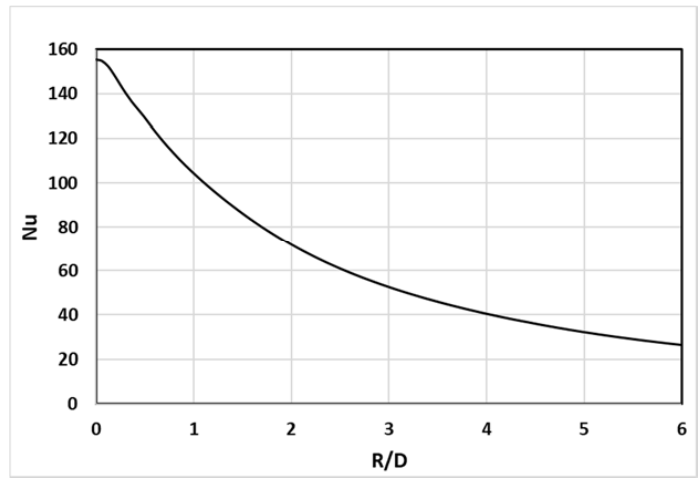
Figure 7. Local Nusselt Number ( N (cid:2931) ) distribution for R e = 20,000 and H/D = 6.